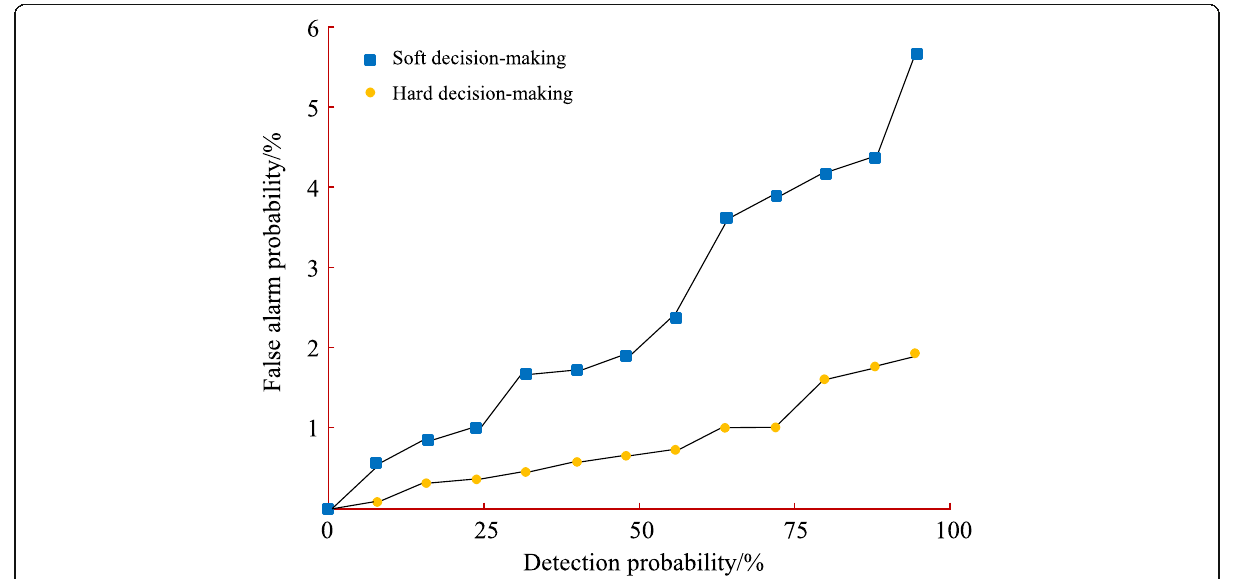
Fig. 5 Decision-making strategies combined with spatial and temporal properties. Figure clearly shows the trend of detection results. The simulation results are shown in Fig.